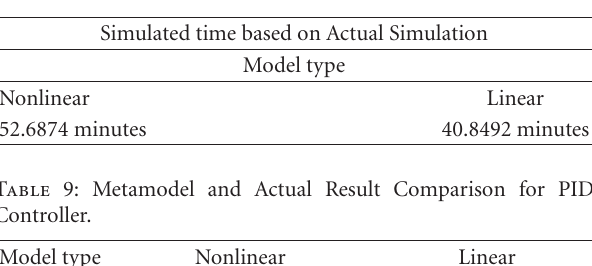
Table 8: Time taken to optimize PID controller parameter using actual simulation.